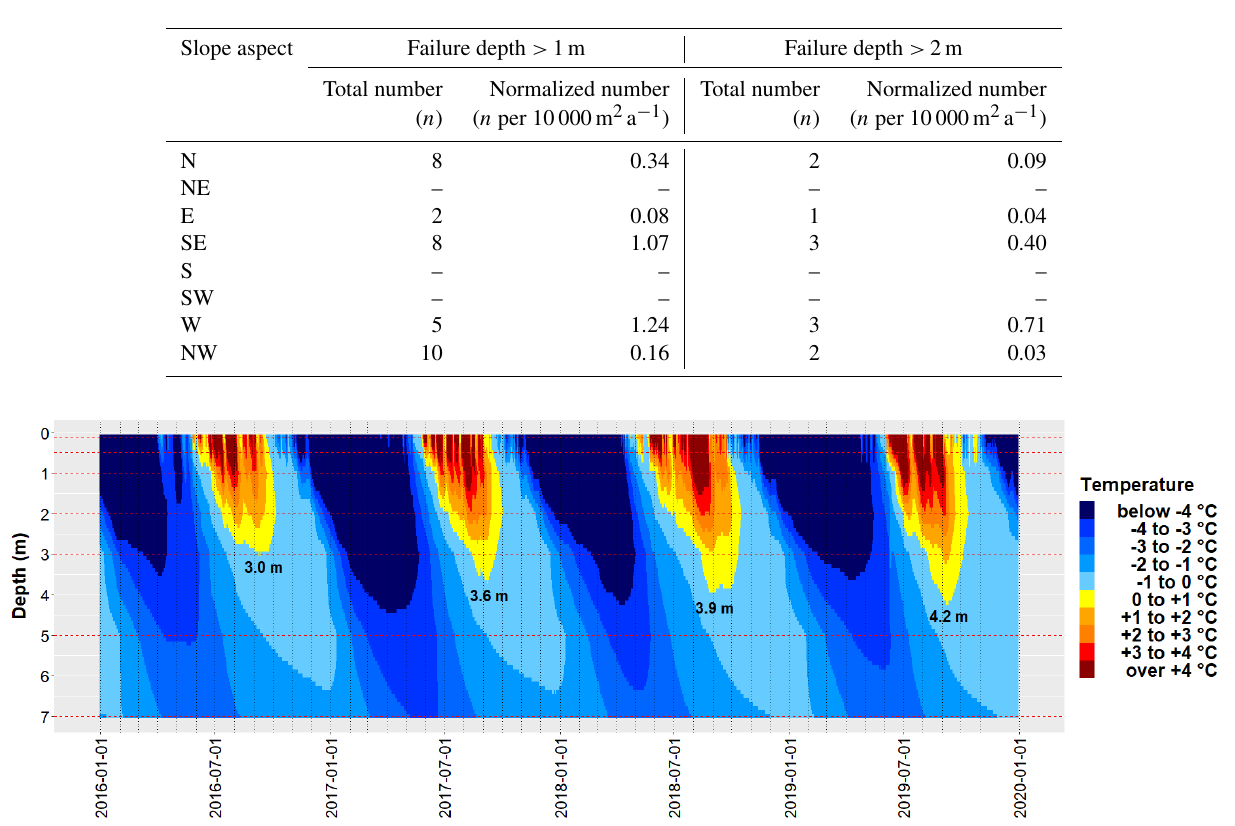
Table 2. Rockfalls with failure depths > 1 and > 2m classified by slope aspect. Rockfalls with failure depths > 1m ( > 2m) are most frequent in W- and SE-facing rockwall sections.